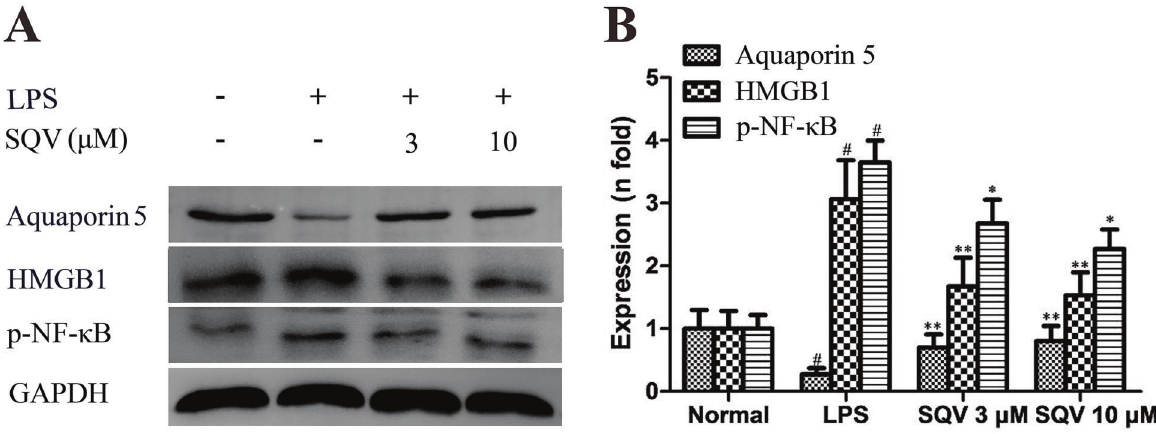
Figure 4. In fl uence of saquinavir (SQV) on high mobility group box 1 (HMGB1), phospho-NF- k B (p-NF- k B), and aquaporin 5 in lipo- polysaccharide (LPS)-stimulated human type I alveolar epithelial cells (AT I) by western blotting. Data are reported as means ± SD